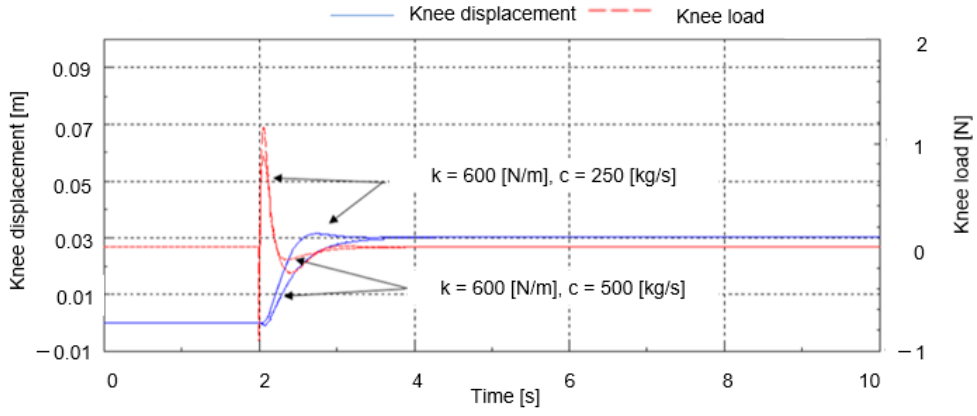
Figure 20. Comparison of device dumper constant increase.